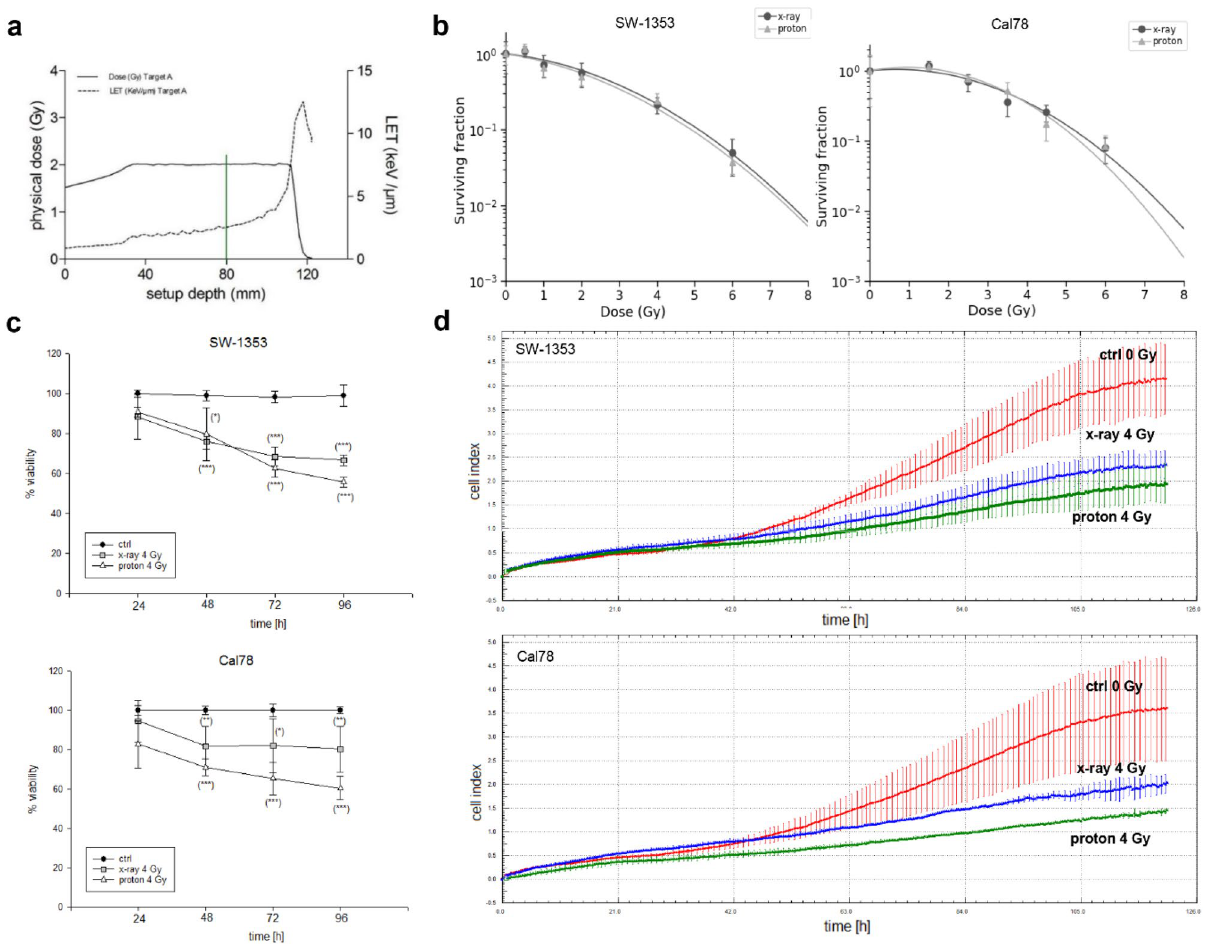
Figure 1. Clonogenic survival, viability and proliferation analysis after photon and proton IR. ( a ) The LETd is based on Monte Carlo calculations and was derived directly from the treatment planning system. ( b ) For clonogenic survival assay SW-1353 and Cal78 cells were harvested immediately after 0.5, 1, 2, 4, and 6 Gy photon (X-ray) and proton IR and seeded according the dose level. Colonies were stained with crystal violet and the surviving fractions were analysed. IR inhibits the ability of chondrosarcoma cells to form colonies dose- dependent manner (mean ± SD; n = 4; measured in sixfold determination). ( c ) Viability and ( d ) xCELLigence real-time proliferation analysis revealed minor differences between the two types of IR on both cell lines (red: unirratiated control cells; blue: X-ray 4 Gy; green: proton 4 DNA ligase IV expression occurred already after a few minutes, while Ku70 remained unchanged (Fig. 5a, right). Very similar effects were observed after X-ray IR. However, the changes in protein expression occurred with a time delay (Fig. 5a, left). In accordance with the RNA sequencing data, the protein expression of MSH3, PCNA, XPC, and EXO1 increased within a very short time as a result of proton IR (Fig. 5b, right). This pathway was also activated significantly later over time by the X-ray IR (Fig. 5b, left). The phosphorylated histone γH2AX was elevated threefold in response to proton IR already after 30 min (Fig. 5c, right), and after 1–2 h with X-ray IR (Fig. 5c, left). The protein expression data confirmed the IF and IHC findings, for instance that DNA damage is repaired largely within 24 h in chondrosarcoma cells. The time-delayed 2.5-fold increase within the first four hours in the expression of the death receptor TRAIL- R2 proved the damage of the chondrosarcoma cells. Proton IR activates the NF-ĸB pathway in chondrosarcoma cells. Whole cell lysates were extracted from the cells 10 min, 30 min, 1 h, 2 h, 4 h, and 24 h after 4 Gy proton IR and prepared for western blot analysis. Fold changes normalized to non-IR controls (Δ ratio; mean ± SD of n = 3) were presented. 30 to 60 min after proton IR there is an increased phosphorylation of IKKα/β (2.6-fold), IĸBα (2.3-fold), p52 (1.7-fold), and p65 (1.8-fold). In this pathway, too, X-ray IR caused a later activation than proton IR (Fig. 6).